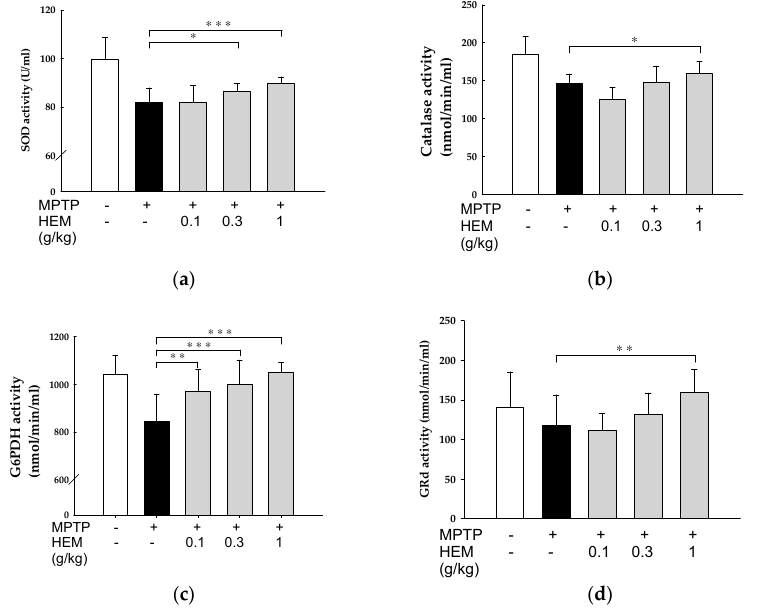
Figure 8. Effect of HEM treatment on the oxidative stress parameters in RBCs. Different parameters were determined, including ( a ) SOD, ( b ) catalase, ( c ) G6PDH, and ( d ) GRd. Values are expressed as mean ± SD. * p < 0.05; ** p < 0.01 and *** p < 0.001 as compared with the MPTP − treated group.